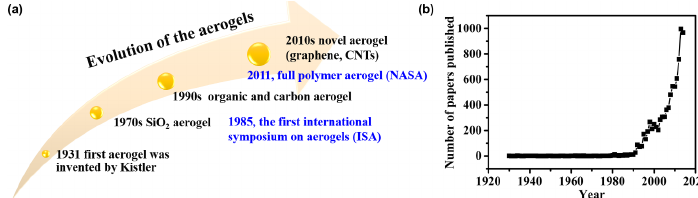
Figure 1. ( a ) Evolution of the aerogels. ( b ) The number of papers published every year during the last decades (search by aerogel from Web of Science).